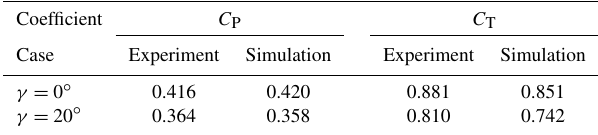
Table 1. Experimental and simulated power and thrust coefficients for the G1 turbine, in the medium-TI